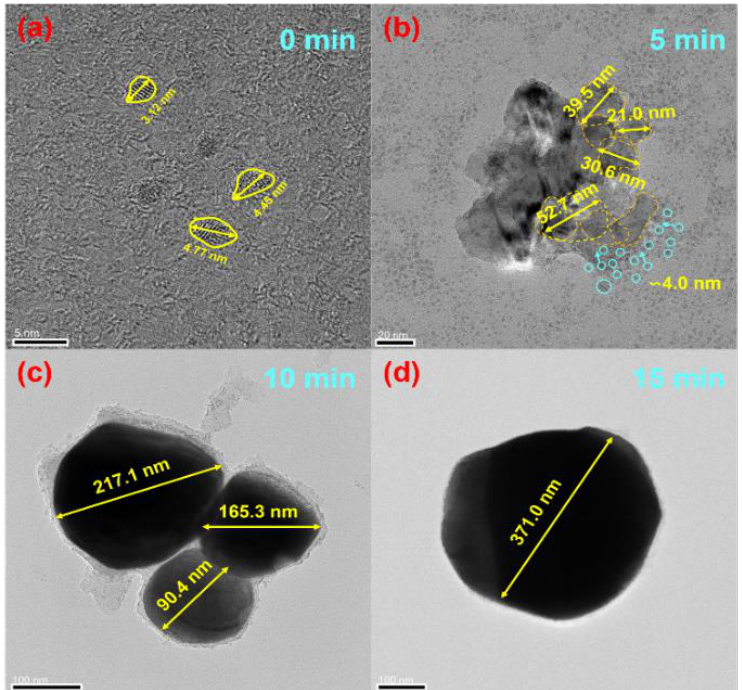
Figure 3. TEM images of CoSn 3 Nps. ( a ) Heating at 350 °C for 0 min; ( b ) heating at 350 °C for 5 min; ( c ) heating at 350 °C for 10 min; ( d ) heating at 350 °C for 15 min.